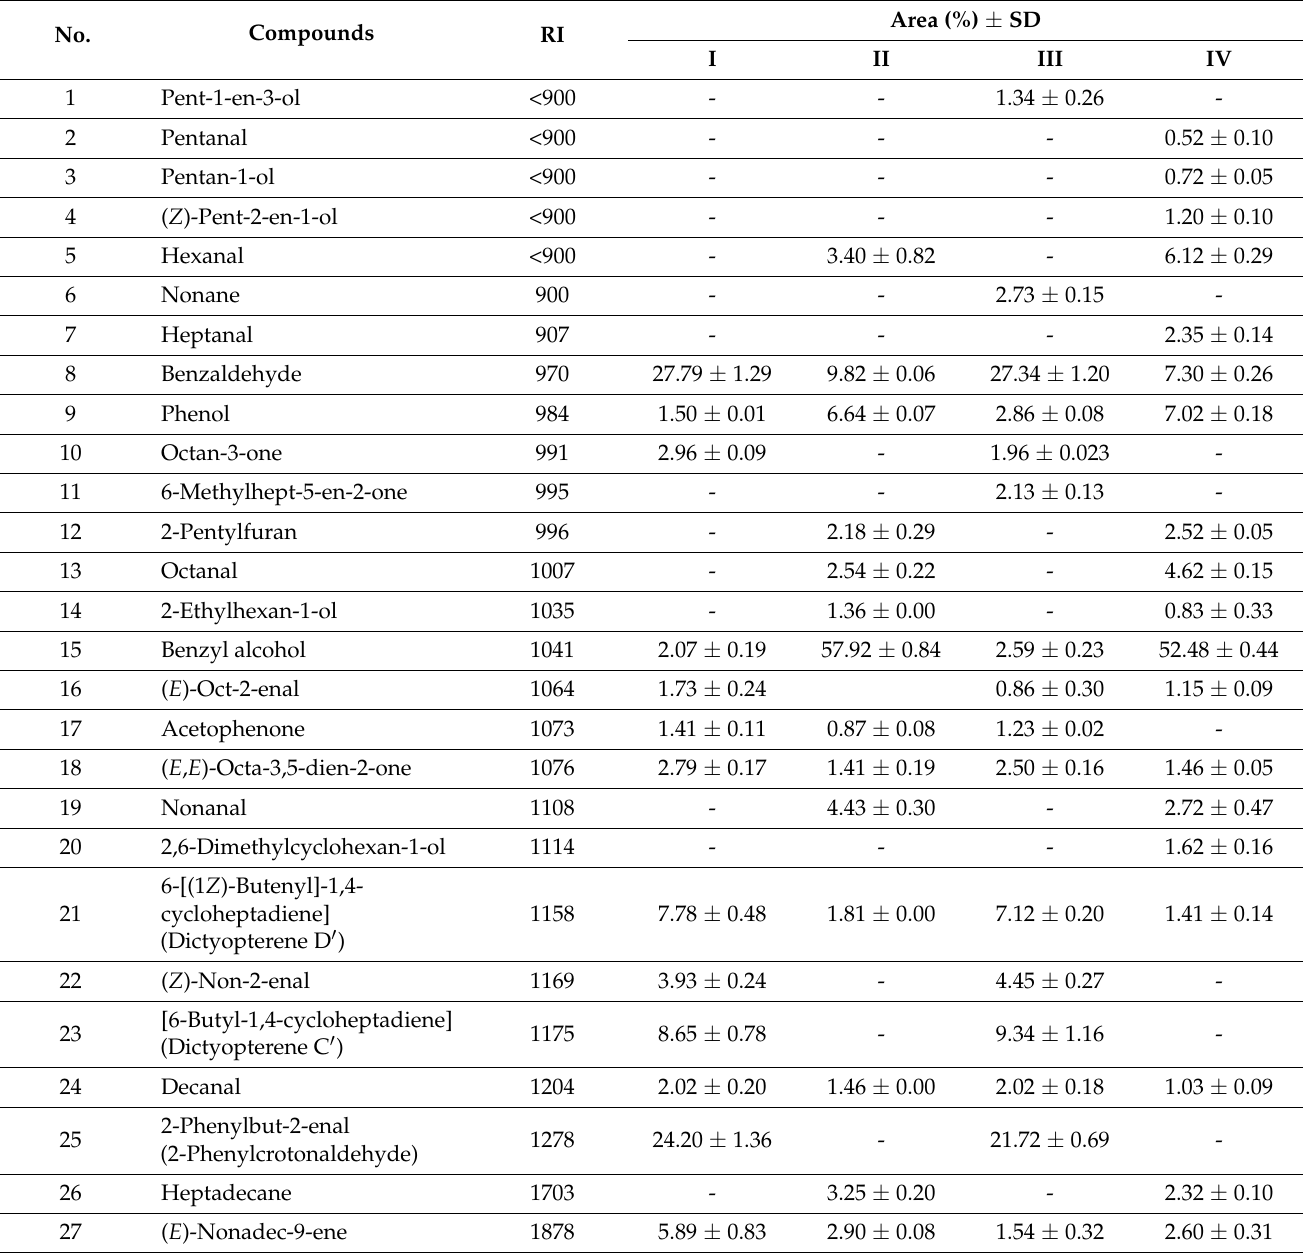
Table 1. The VOCs from D. vermicularis isolated by headspace solid-phase microextraction (HS- SPME) and analysed by gas chromatography–mass spectrometry (GC–MS): (I—fresh D. vermicularis extracted by DVB/CAR/PDMS fibre, II—air-dried D. vermicularis extracted by DVB/CAR/PDMS fibre, III—fresh D. vermicularis extracted by PDMS/DVB fibre, IV—air-dried D. vermicularis extracted by PDMS/DVB